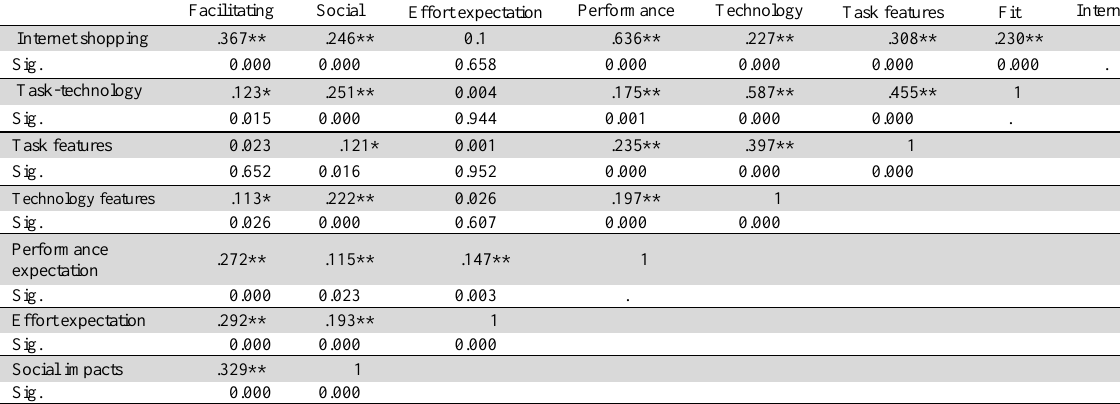
The correlation matrix Facilitating Social Effort expectation Performance Technology Task features Fit